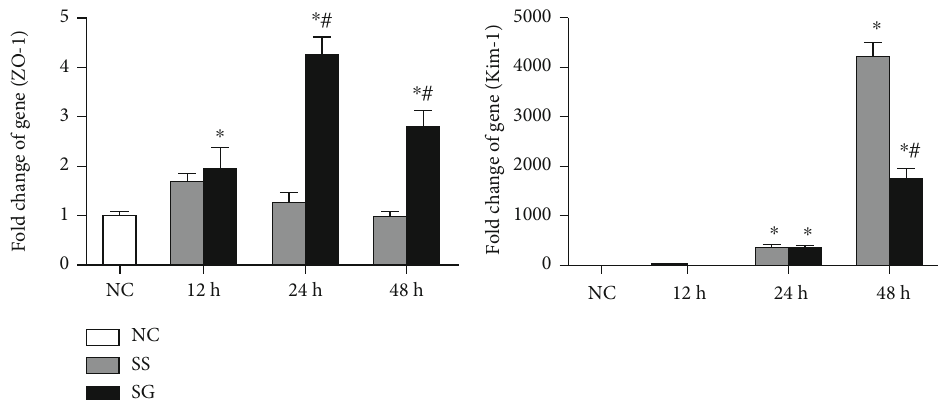
Figure 4: Expressions of genes related to kidney tissue injury. NC: normal control; SS: sepsis group with saline; SG: sepsis group with glutamine; ZO-1: zonula occluden-1; Kim-1: kidney injury molecule. Messenger RNA changes were quantitated and analyzed by a real- time PCR and were calculated by the comparative CT (2 - ΔΔ Ct ) method. mRNA expression levels in the normal control group were used as a calibrator. Values are expressed as the mean ± SEM . n = 8 for each group at 12, 24, and 48 h after cecal ligation and puncture (CLP). Di ff erences between 2 sepsis groups at the same time point were analyzed by t -test. The comparison among NC and the sepsis groups at three di ff erent time points were analyzed by a one-way analysis of variance (ANOVA) followed by Tukey ’ s post hoc test. ∗ Signi fi cantly di ff ers from the NC group; # signi fi cantly di ff ers from the SS group at the same time point ( p < 0 : 05